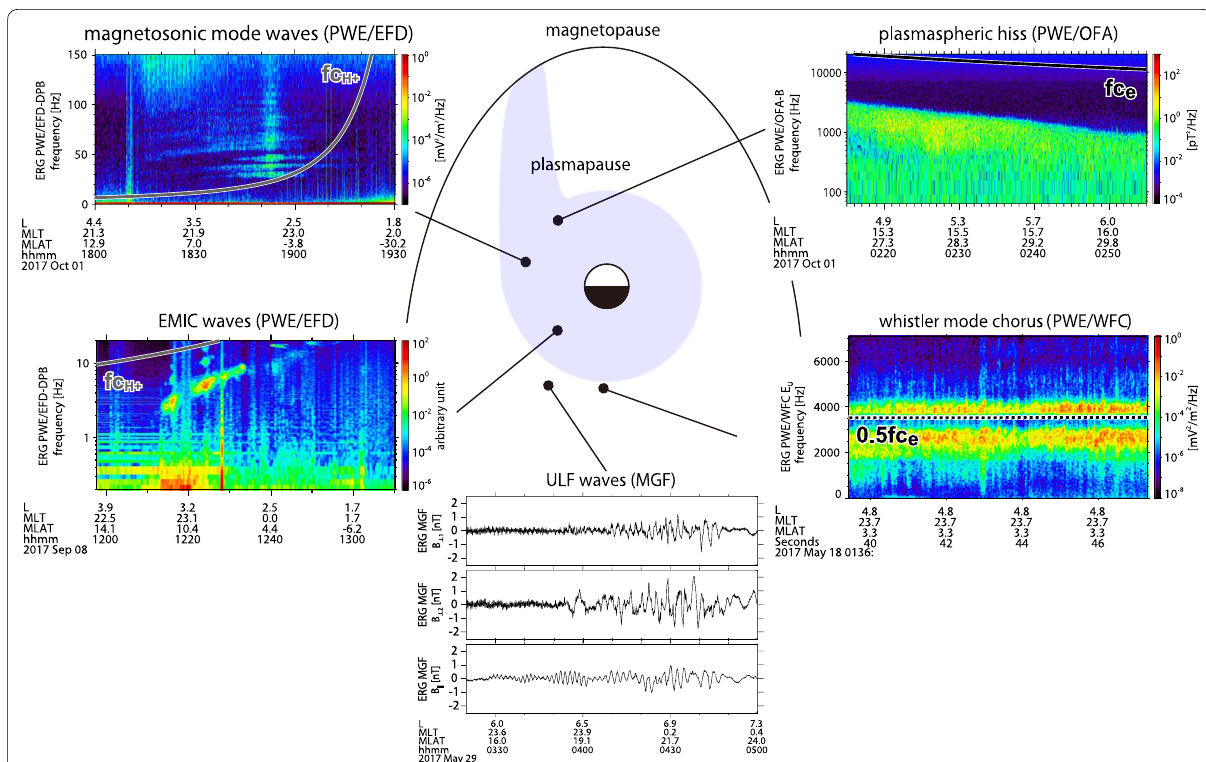
Fig. 7 Examples of plasma waves observed by the ERG satellite. Frequency‑time diagram for whistler mode chorus waves, whistler mode hiss waves, magnetosonic mode waves (equatorial noise), and EMIC waves. Waveform plots for Pc4 and Pc5 pulsations are also